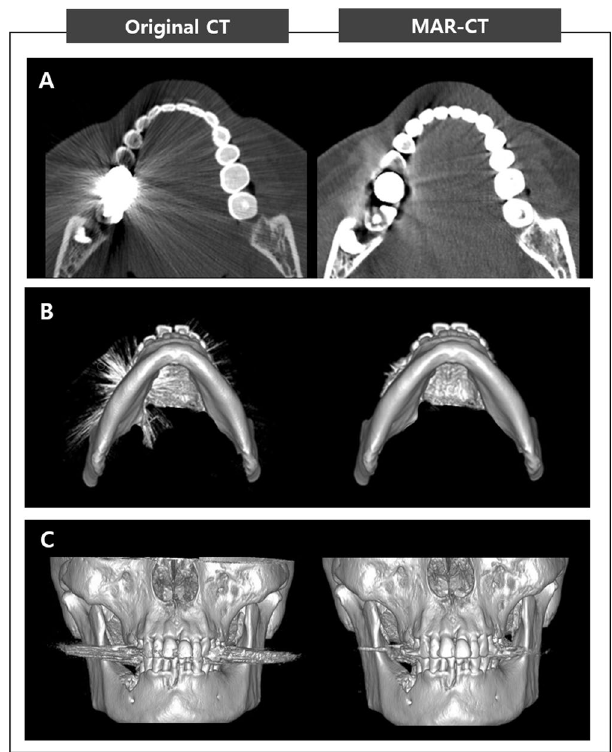
Figure 3. Original CT and MAR-applied CT. ( A ) Axial view, ( B ) volume rendering image (bottom view), ( C ) volume rendering image (frontal view). Note the significant reduction of metal artifacts in the MAR-CT image compared to the original CT. MAR metal artifact reduction.